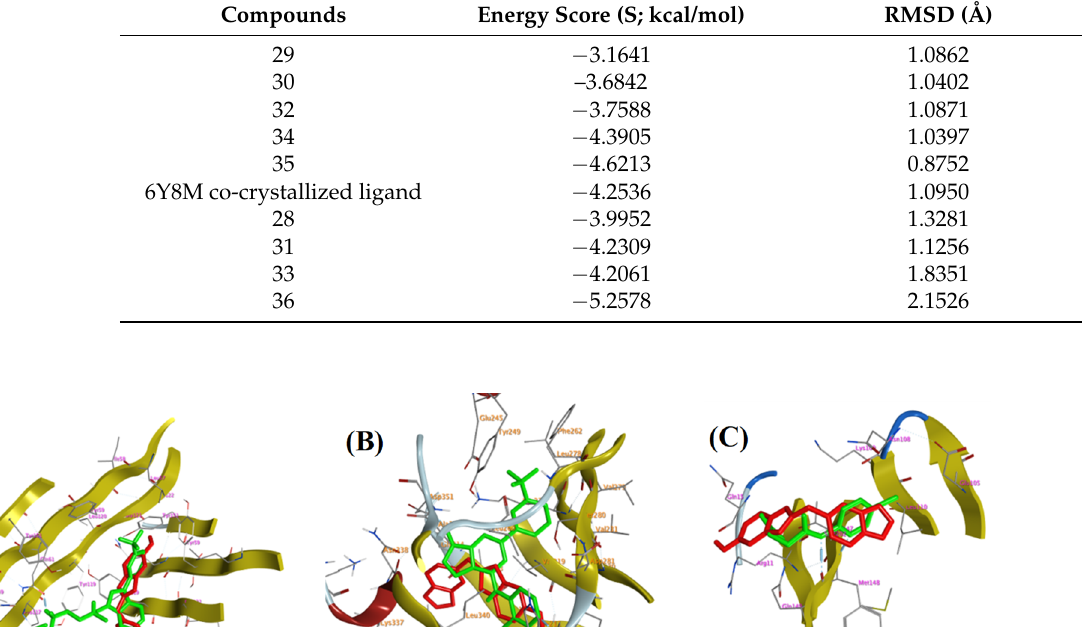
Figure 12. Docking poses of co-crytallized ligand (green) and compound 1 (red) within: ( A ) TNF α (PDB ID: 2AZ5); ( B ) TGFBR1 kinase (PDB ID: 6B8Y); ( C ) IL-1 β (PDB ID: 6Y8M).